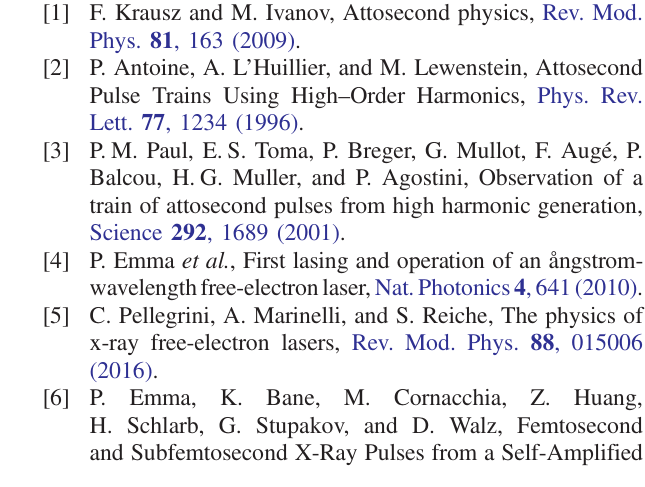
TABLE II. Simulation parameters. Electron